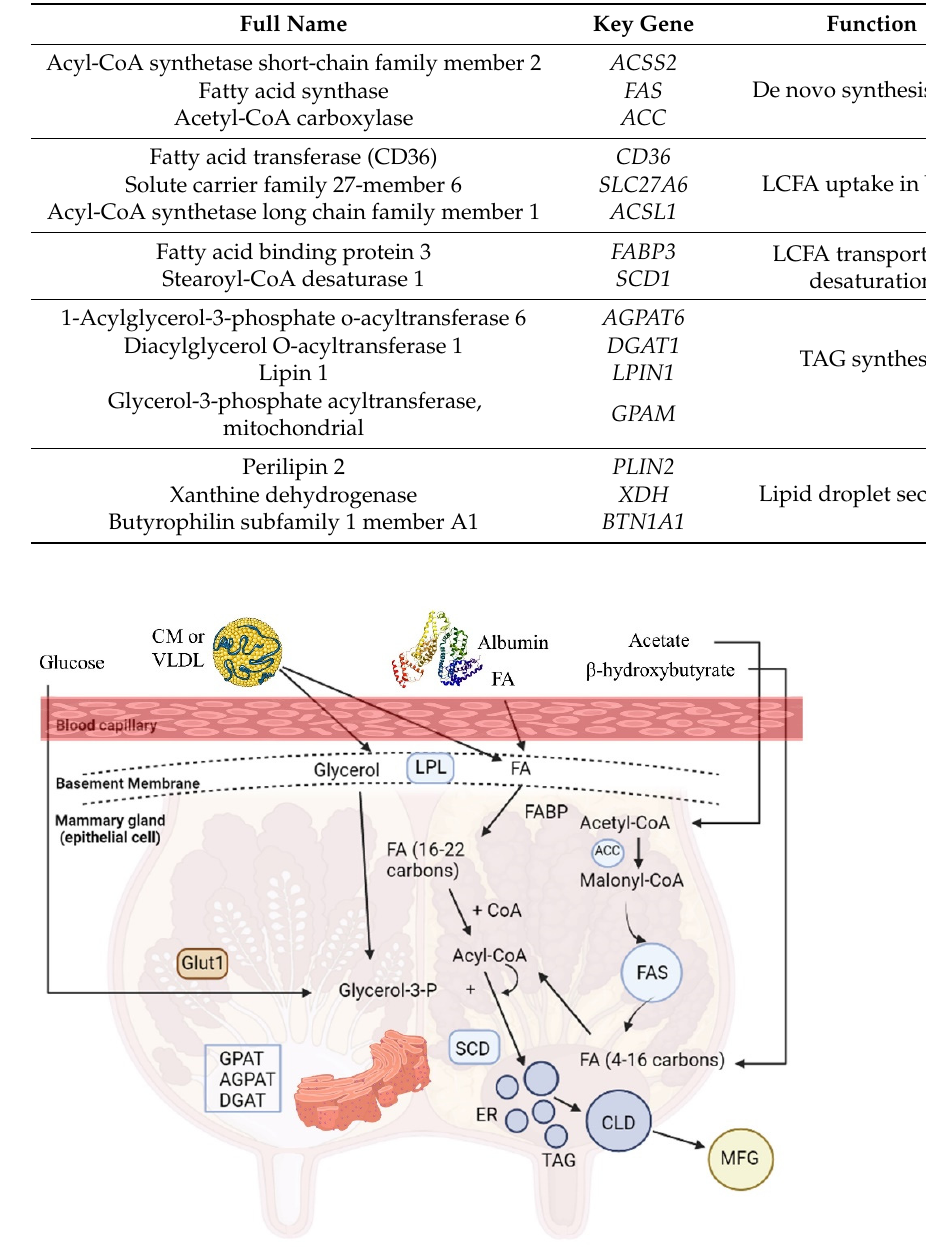
Table 1. Key genes involved in milk fat synthesis in ruminants [17].